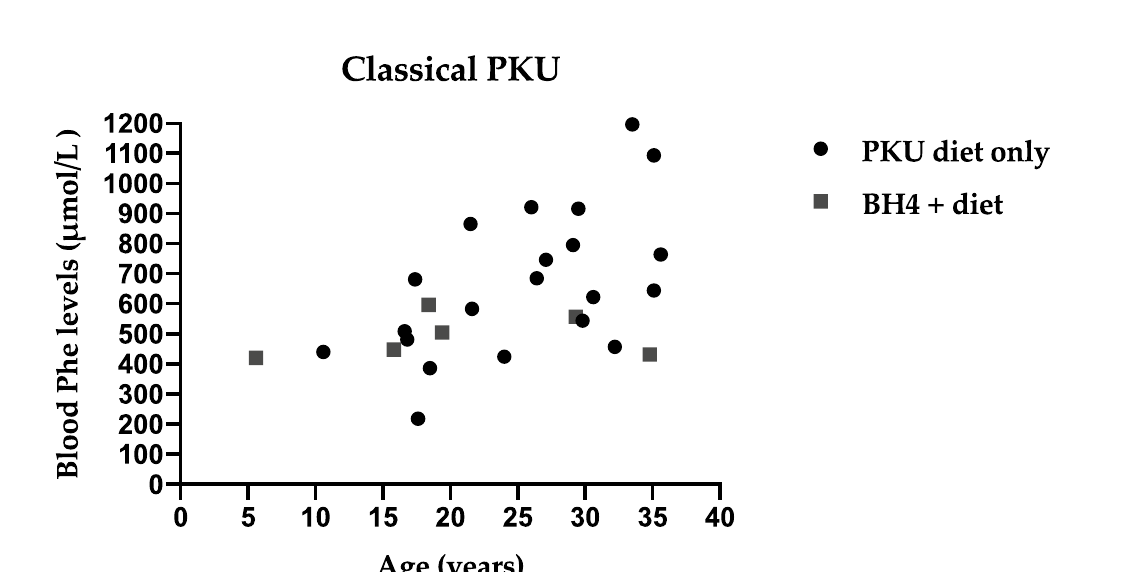
Figure 3. Median annual blood Phe levels for each individual patient with Classical PKU by age and type of treatment.